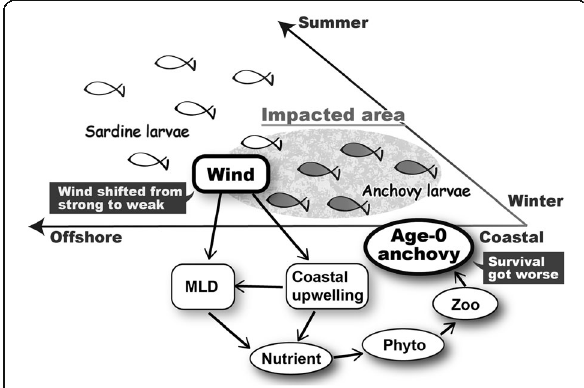
Fig. 20 Conceptual summary of regime shift effects on sardine and anchovy based on the analysis of the historical simulation. Schematic diagram illustrating a chain reaction from the wind regime shift after 1977 to anchovy and sardine dynamics. The weakened wind speed from autumn to early spring links to the low food density in the coastal area, which affects many of the anchovy larvae. Consequently, age-0 anchovy survival is reduced after the regime shift. On the other hand, most of the sardine larvae that were distributed in the offshore region from spring to summer were unaffected by the regime